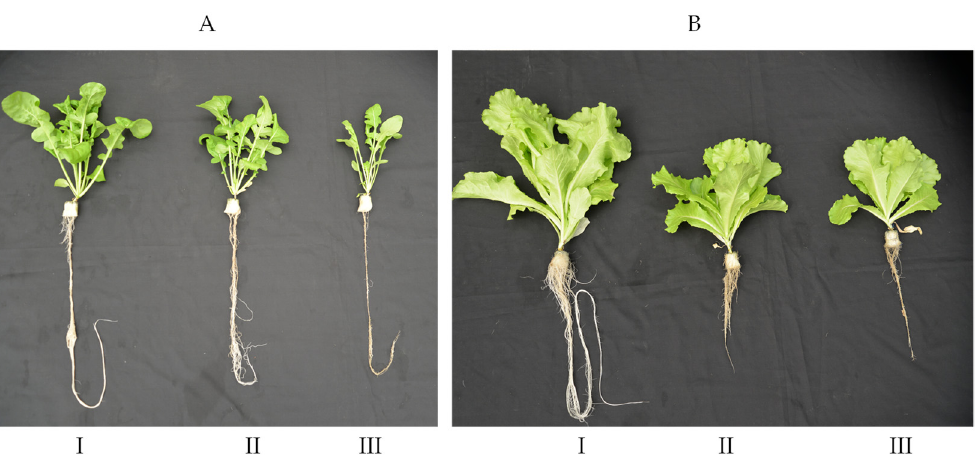
Figure 3. Arugula ( A ) and Canasta ( B ) plants grown under different RZTs at harvest (36 DAT). I, 25 ◦ C-RZT; II, 25 ◦ C-RZT → 38 ◦ C-RZT → 42 ◦ C-RZT (RZ heat primed plant) and III, 25 ◦ C-RZT → 42 ◦ C-RZT (non-primed plant). Refer to Section 4.2 for further details on different RZT treatments.